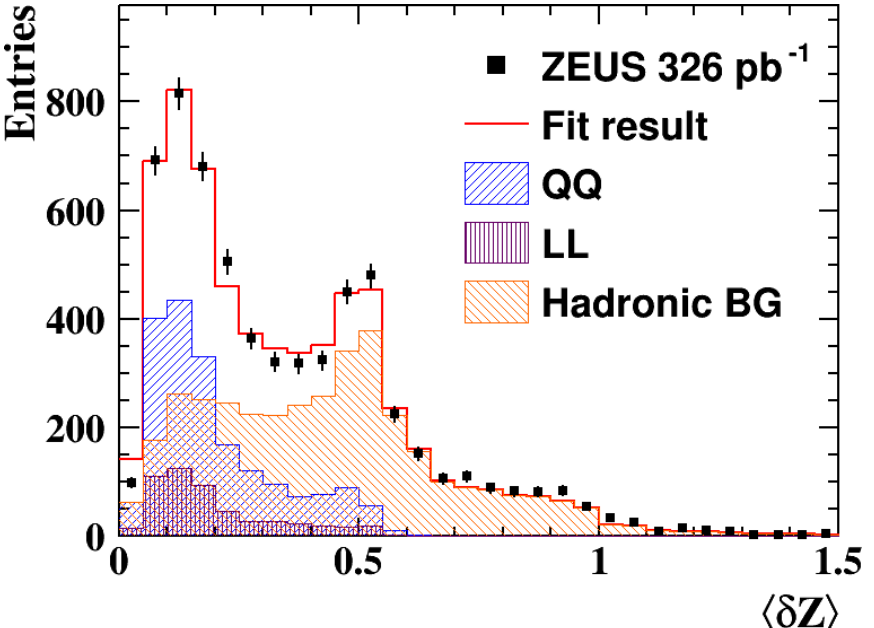
Figure 2 . Distribution of h (cid:14)Z i for the full data sample. The error bars represent the statistical uncertainties on the data points. The solid line shows a (cid:12)t to the data of three components with (cid:12)xed shapes as described in the text. The hatched histograms represent the LL and (cid:12)tted QQ components of the (cid:12)t and the (cid:12)tted hadronic background